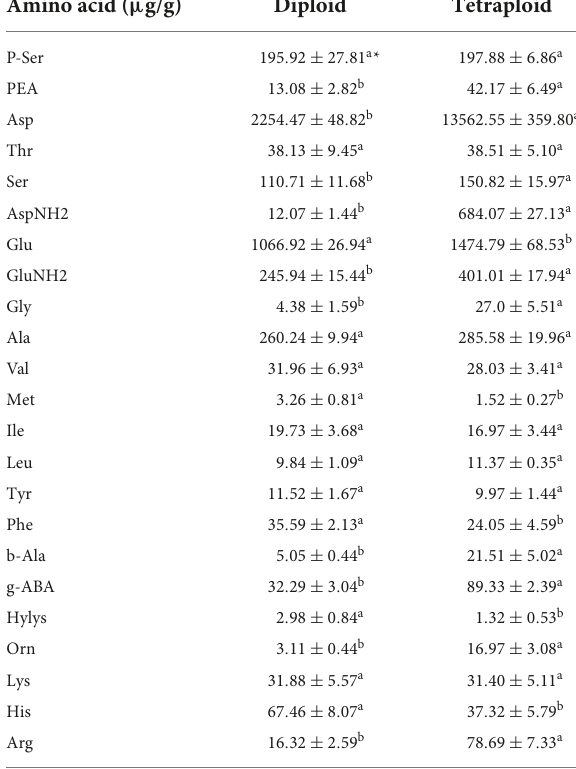
TABLE 2 Free amino acid content of diploid and tetraploid Anoectochilus roxburghii.